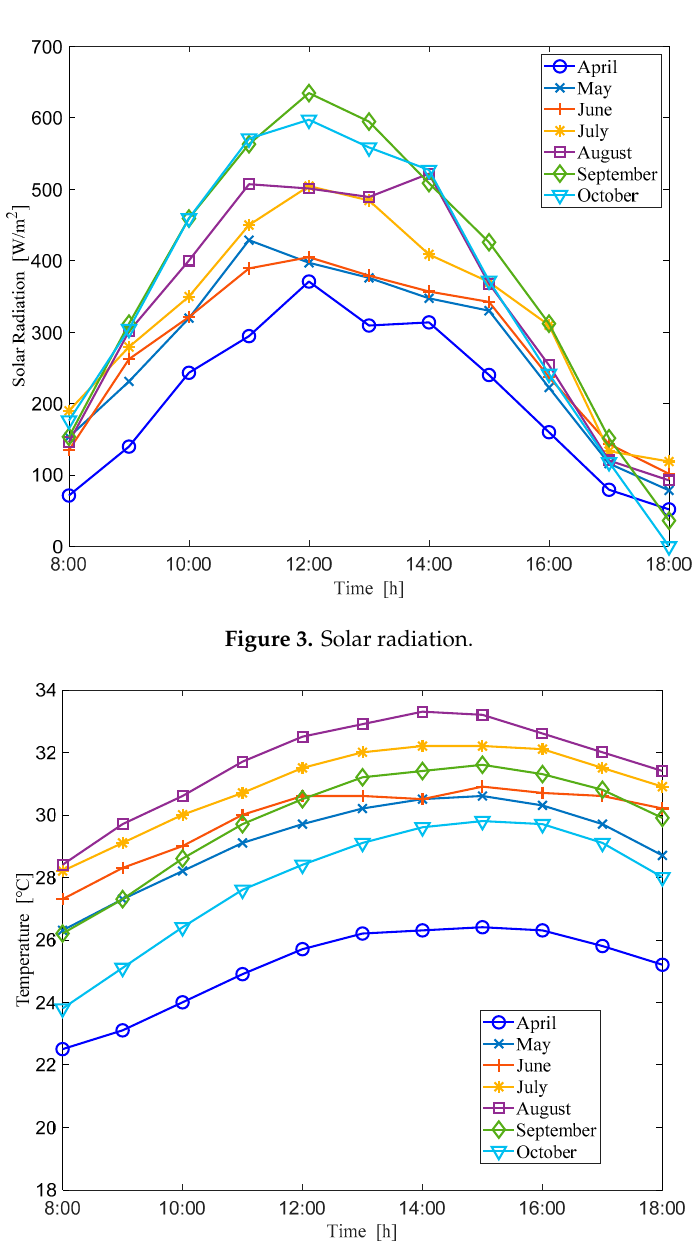
Figure 4. Ambient